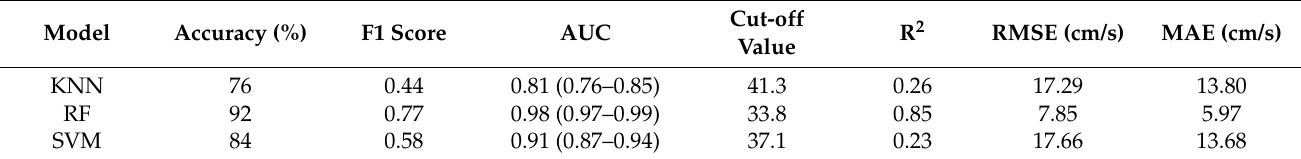
Table 3. Comparison of the predictive performance for three models in the training set.